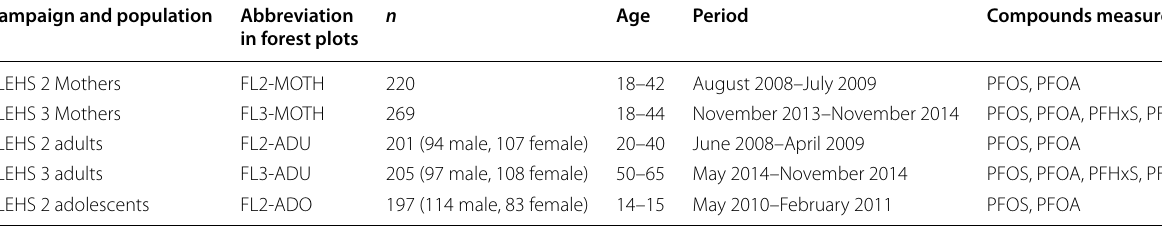
Table 1 Summary data on participants with mention of compounds measured Campaign and population